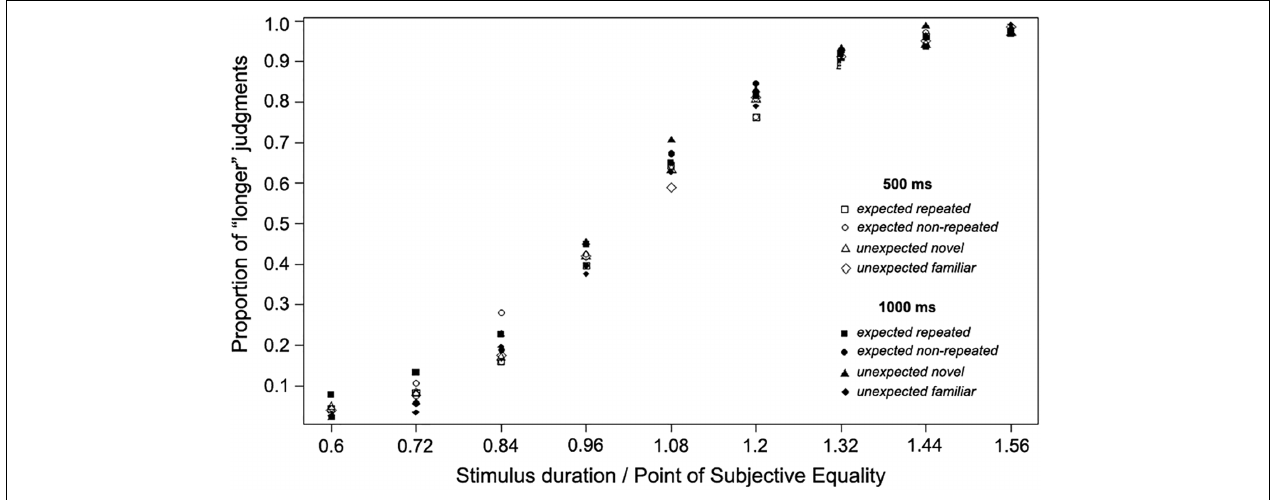
FIGURE 6 | Proportion of “long” judgments made across Experiments 1 and 2, plotted using the same relative scale, normalized for short (500 ms) or long (1,000 ms) temporal scale of stimulus